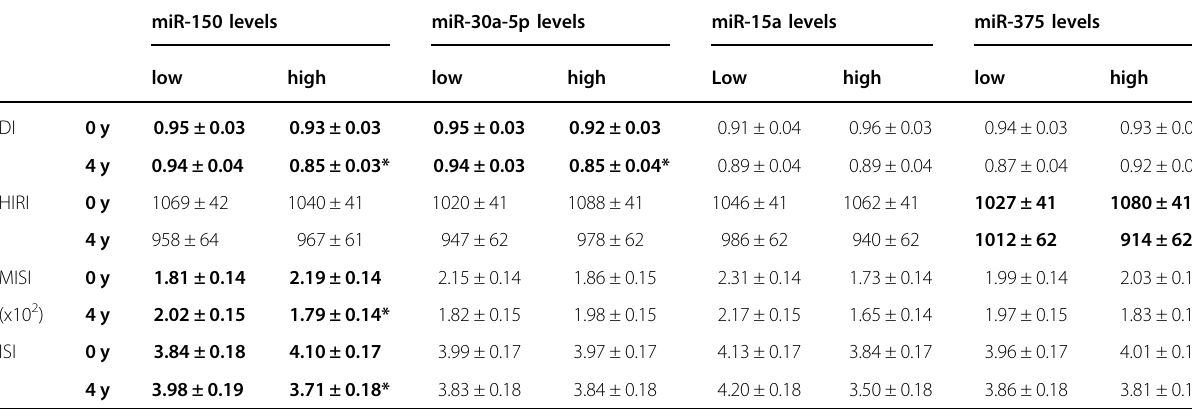
Values are expressed as the mean±SEM and were obtained by ANOVA for repeated measures. Low: Low circulating levels of miRNAs; High: High circulating levels of miRNAs. Statistical signi fi cance was evaluated by the Wilcoxon test using SPSS (now PASW Statistics for Windows (version 21.0) (IBM. Chicago, Illinois)) *Statistically signi fi cant differences ( p <0.05) are in